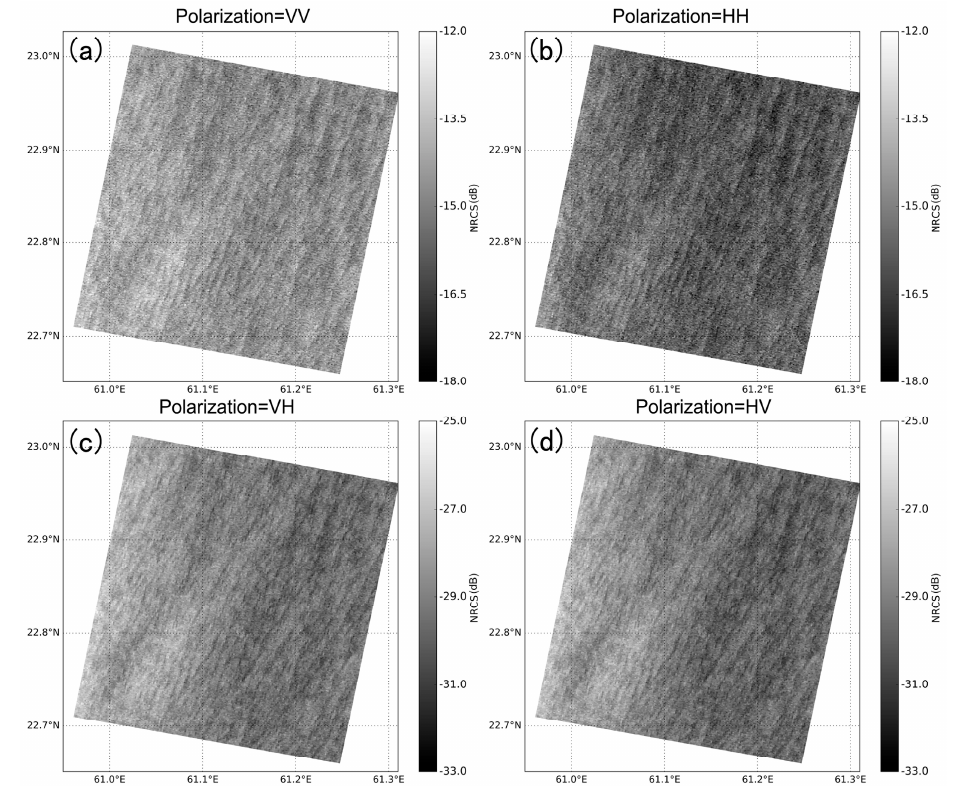
Figure 3. Normalized radar cross-section (NRCS) from GF-3 QPSI mode quad-polarization SAR data acquired on 3 July 2017 at 01:51:53 UTC for ( a ) VV, ( b ) HH, ( c ) VH, and ( d ) HV polarization.